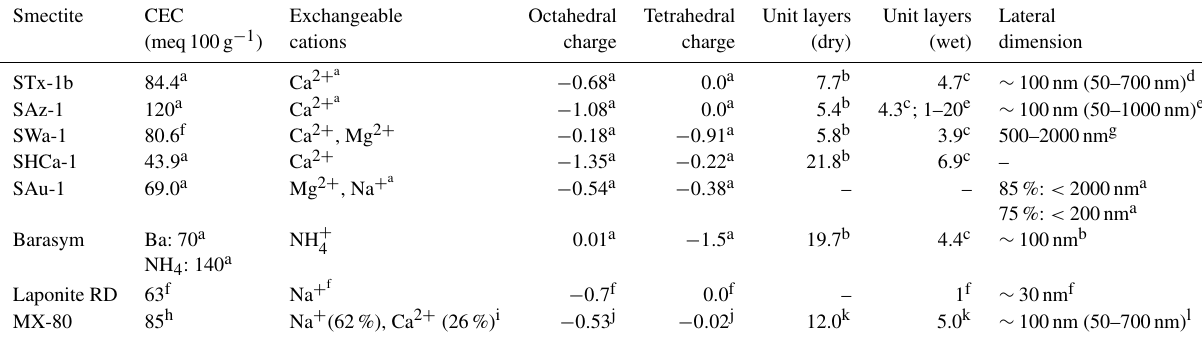
Table 3. Physicochemical properties of the investigated